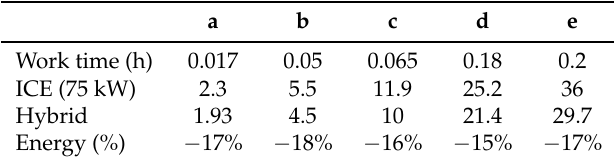
Table 5. Tasks experimental characterization overview: (a) Trailer 6000 kg; (b) Trailer 1400 kg; (c) Atomizer; (d) Shredder; and (e) Rotary